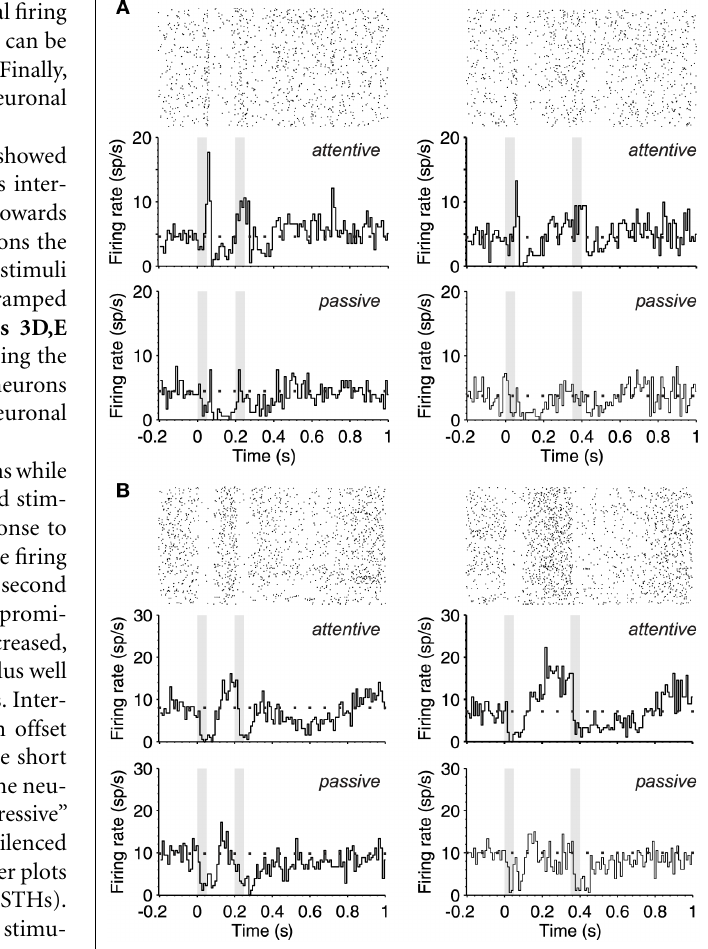
FIGURE 2 | Ramping-up activity during the interstimulus interval. (A) Upper part. PSTH (180 trials) of the response (bottom) and raster plot (top) of a single neuron during the attentive task shows the response pattern to two identical stimuli (50ms; 80dB; 5322Hz) separated by 150ms (left) and 300ms (right).The gray boxes correspond to the periods of auditory stimulation.The PSTH shows an offset response to stimulus 1 and onset response during stimulus 2 while in the passive brain state (lower part) there is an overall decrease of excitability and no monotonic increase of spontaneous activity toward S2 presentation. (B) Same as in (A) , but this other neuron is silenced by the auditory stimulation followed by an increase of firing until S2 occurrence (upper part), while in the passive brain state (lower part) the neuronal firing is markedly reduced. In (A,B) the mean spontaneous activity is represented with a dotted